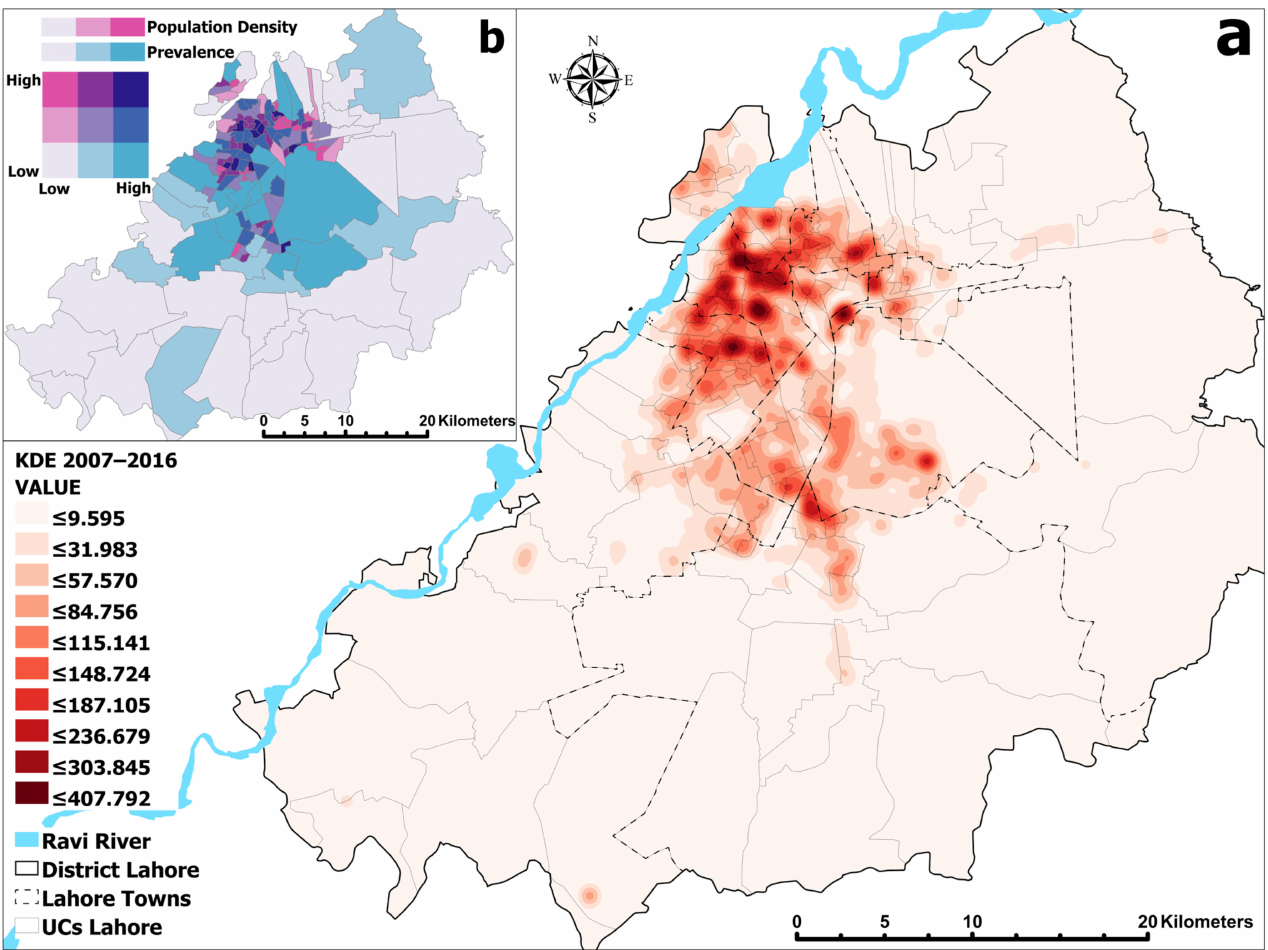
Figure 6. ( a ) Kernel Density Estimation showing the magnitude of dengue cases (2007–2016), ( b ) bivariate correlations at UC level, between Lahore Population Density and DF Prevalence